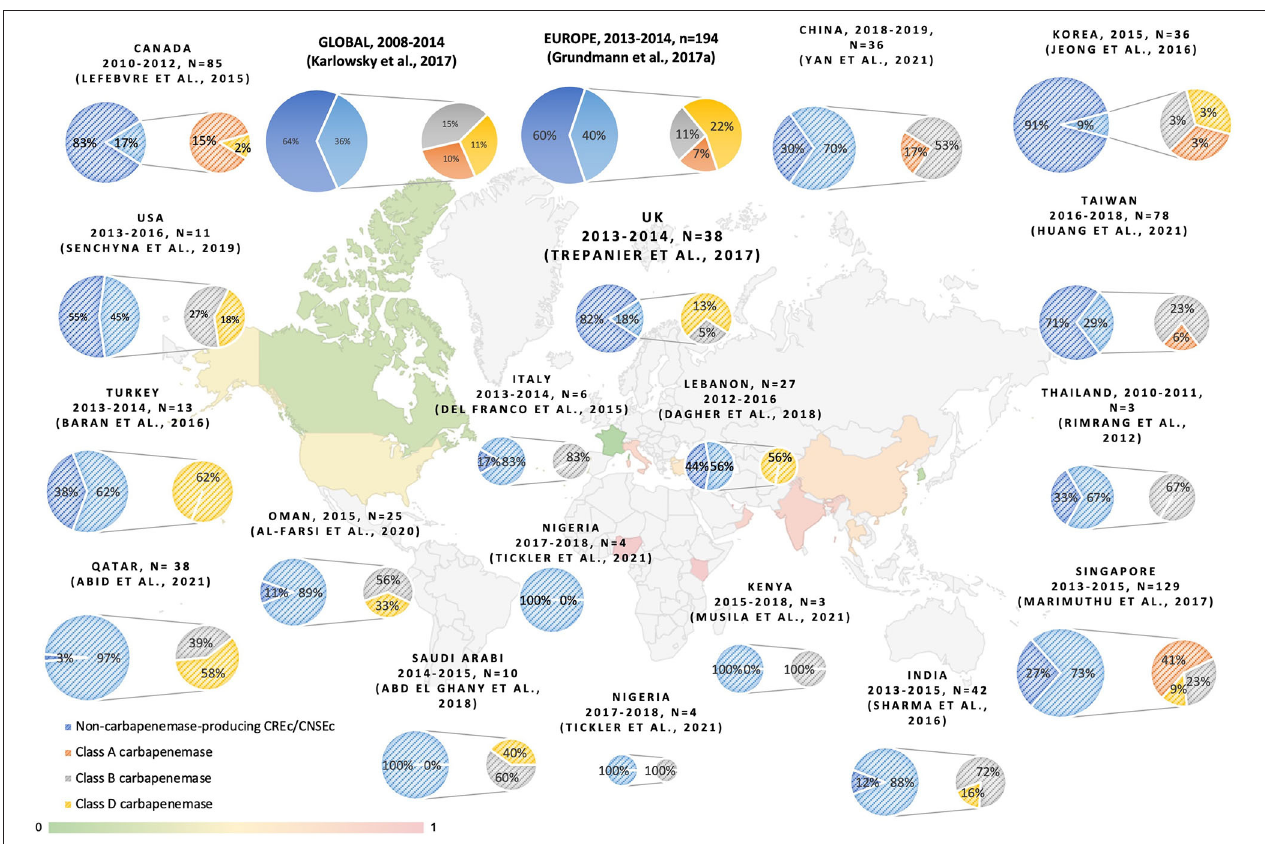
FIGURE 3 | The reporting proportion of non-CP-CRE and carbapenemase among CREc/CNSEc (Rimrang et al., 2012; Del Franco et al., 2015; Lefebvre et al., 2015; Baran and Aksu, 2016; Dupont et al., 2016; Jeong et al., 2016; Sharma et al., 2016; Grundmann et al., 2017; Karlowsky et al., 2017; Marimuthu et al., 2017; Trepanier et al., 2017; Abd El Ghany et al., 2018; Dagher et al., 2018; Senchyna et al., 2019; Al-Farsi et al., 2020; Abid et al., 2021; Huang et al., 2021a; Musila et al., 2021; Tickler et al., 2021; Yan et al., 2021).